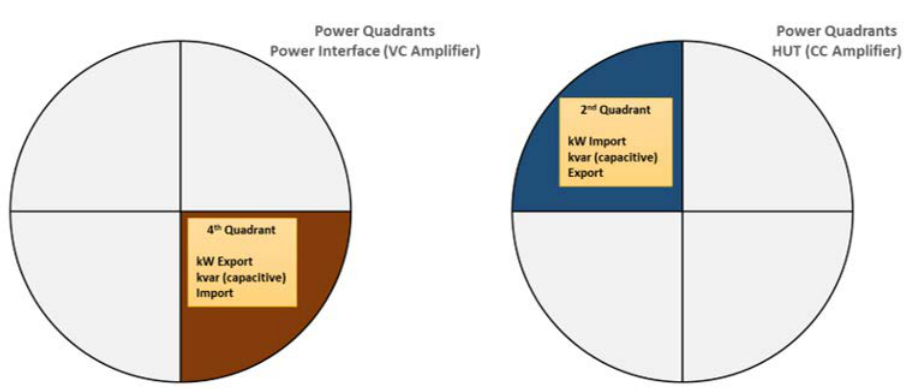
Figure 13. Power quadrants illustrating specific operation of the power components in PHIL